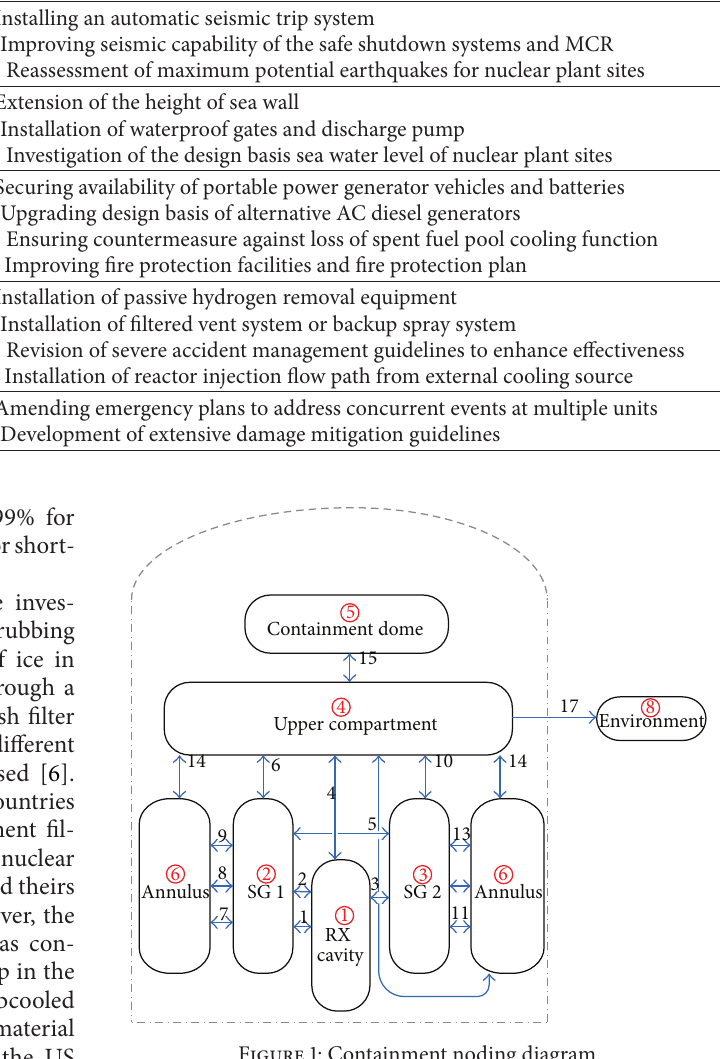
Figure 1: Containment noding